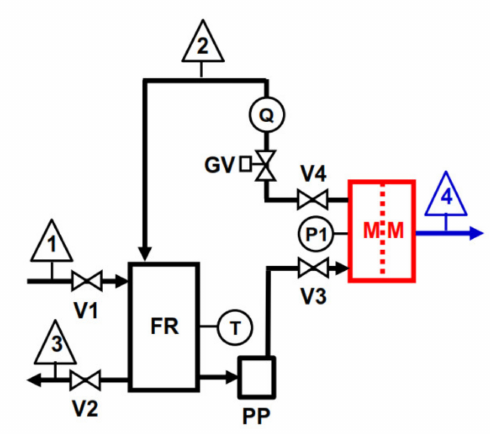
Figure 2. Laboratory-scale RO plant scheme: 1 = feed inlet; 2 = concentrate outlet (recycled); 3 = feed outlet; 4 = permeate outlet